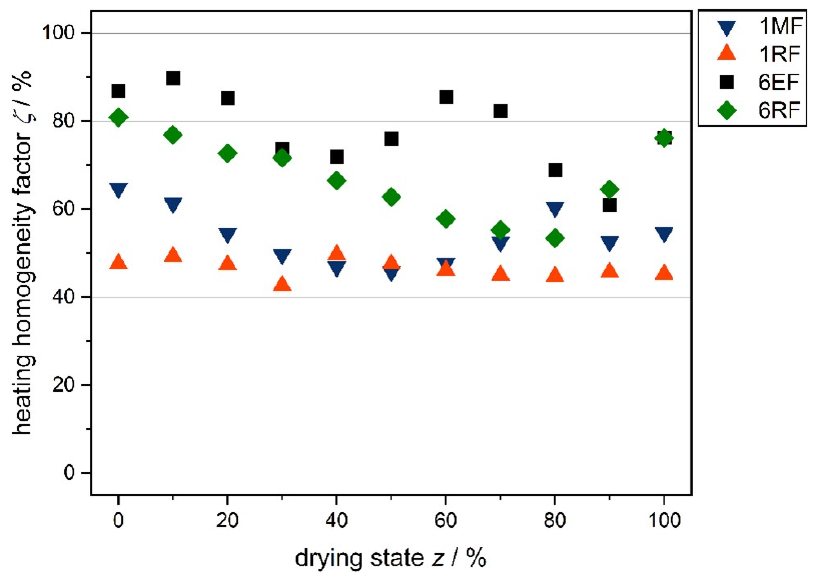
Figure 10. Heating homogeneity factor for the investigated control concepts as a function of the drying state, determined from the electromagnetic simulations.